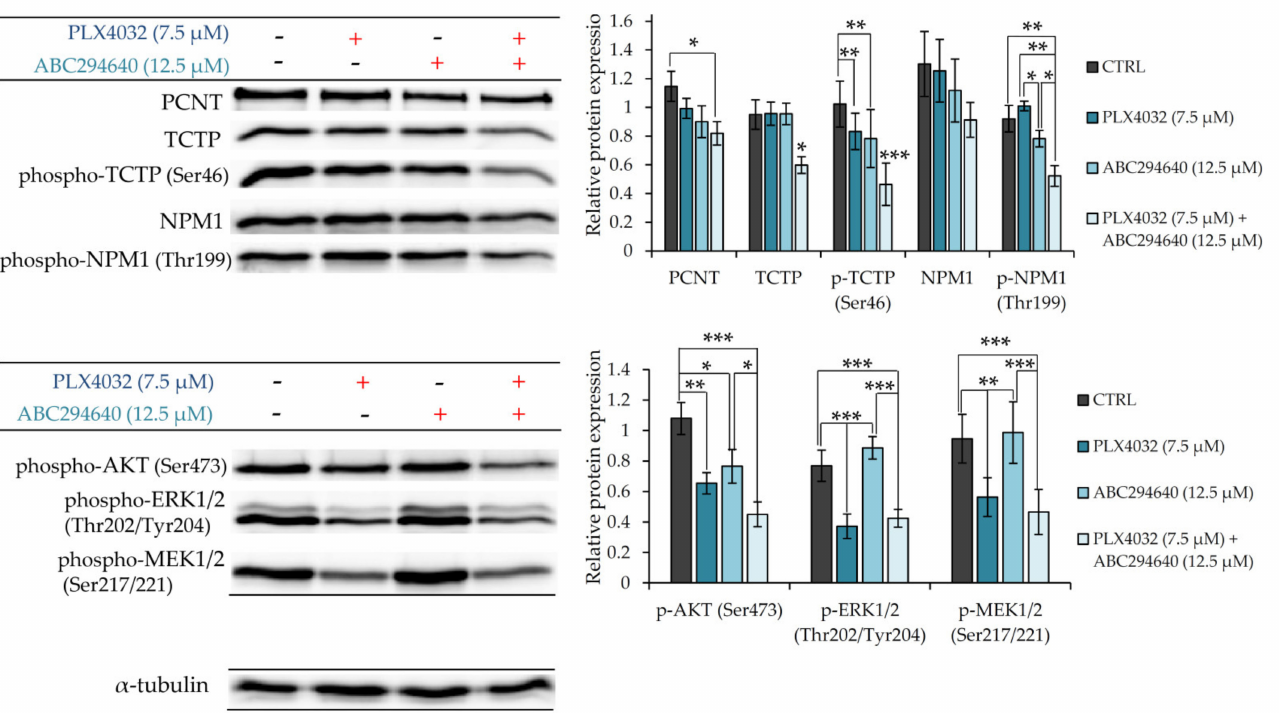
Figure 8. Western blot validation of major proteomic findings indicating the involvement of proteins regulating centrosome biology and cell division in chemosensitizing effect of combination treatment with ABC294640 and PLX4032. Resistant RKOr cells were treated with either PLX4032 (7.5 µ M), ABC294640 (12.5 µ M) or their combination for 72 h. Relative protein expression was measured using Quantity One software for densitometry analysis of western blot bands. Data were obtained from two independent biological experiments performed in technical duplicates. α -tubulin was used as loading control. Statistical significance is denoted with an asterisk (* p < 0.05, ** p < 0.01, *** p < 0.001). PCNT (Pericentrin), TCTP1 (Translationally-Controlled Tumour Protein), NPM1